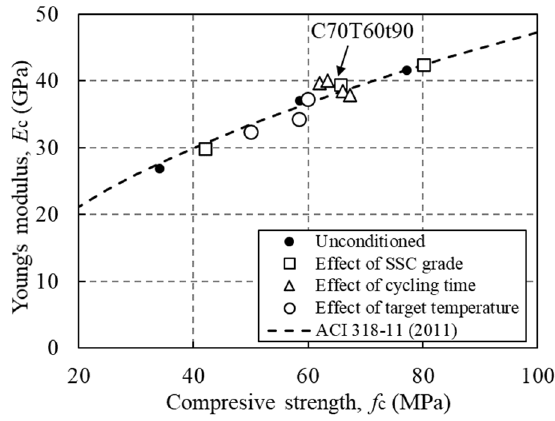
Figure 8. Young’s modulus of SSC.